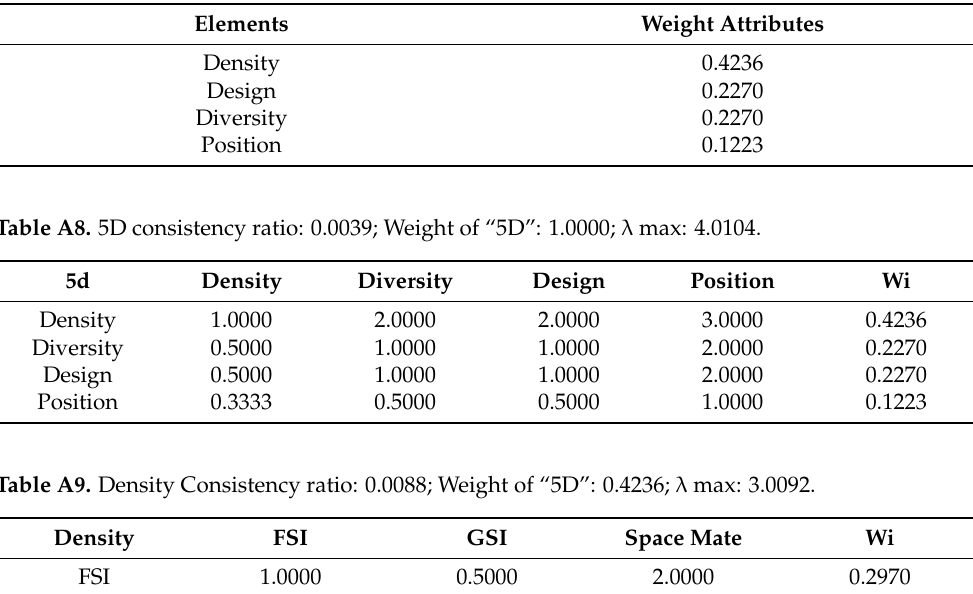
Table A7. Ranking weight of elements in the first intermediate layer for decision objectives.